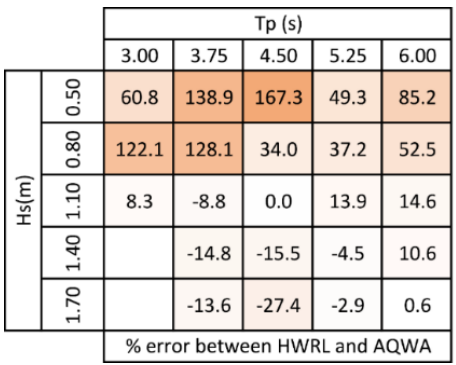
Figure 13. Percent error between measured tank testing data and AQWA model